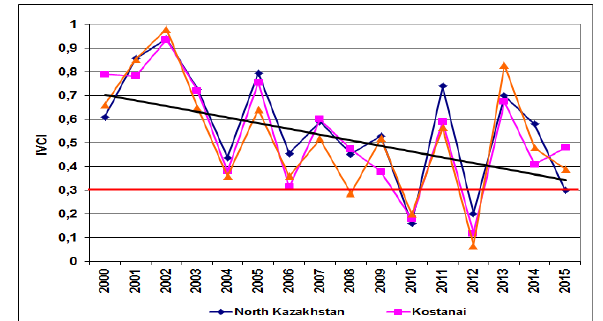
Figure 3. Areas of zones of different vegetation productivity on the Kazakhstan territory (defined by the IVInorm values,